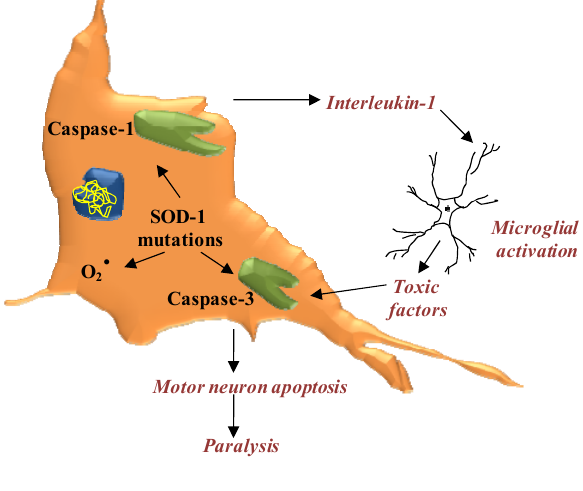
Figure 5. Schematic of SOD-1 mutations activating cell death pathways in